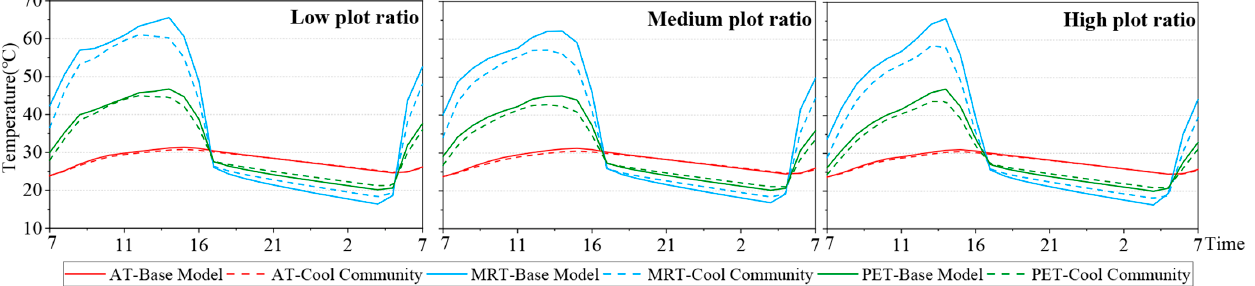
Figure 7. The changes in AT, MRT, and PET in pedestrian height in BM and CC in the three types of districts over time (20 August ).